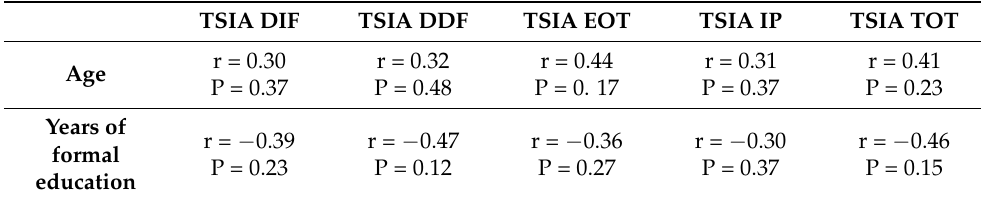
Table 1. Sociodemographic